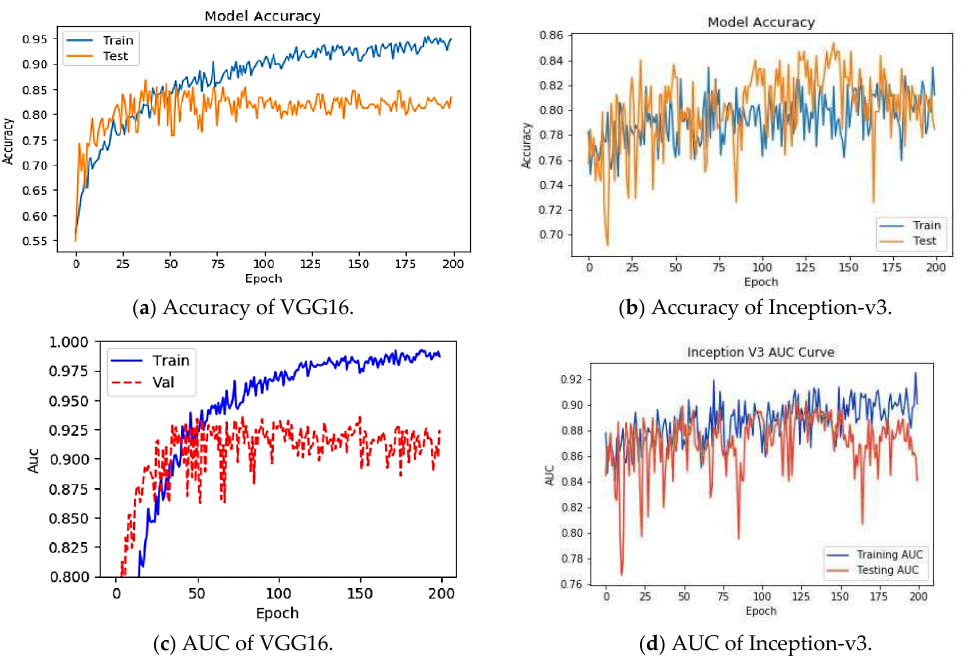
Table 7. Confusion matrix for performance of Inception-v3 on CT scans.